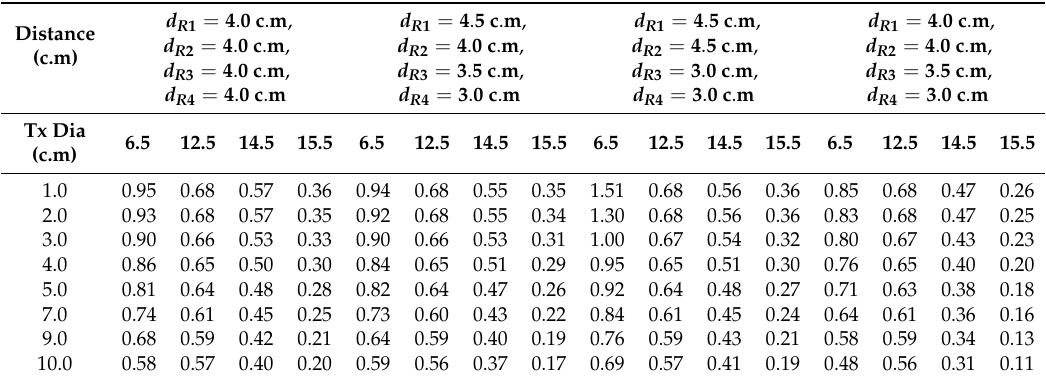
Table 2. Mutual inductance at different Tx and Rx coil diameters.